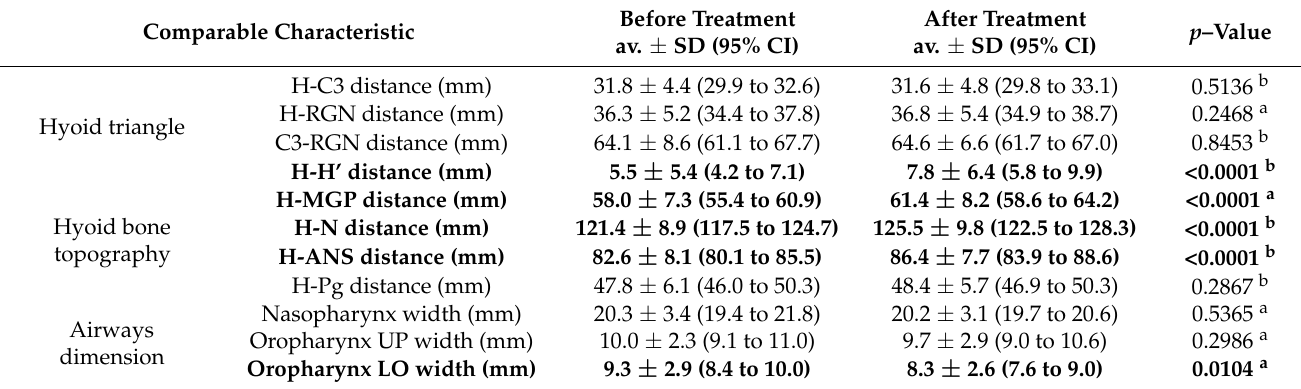
Table 4. Assessment of changes in the hyoid bone position and the width of nasopharynx and oropharynx after occlusal splint therapy combined with physiotherapy in patients diagnosed with temporomandibular joint